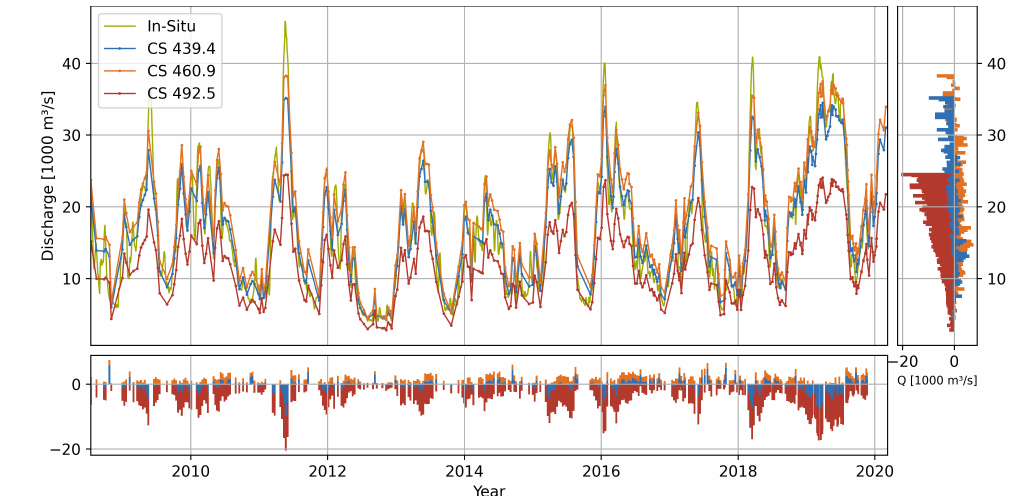
Figure 13. Discharge time series with residuals per time (horizontal) and discharge (vertical) of selected cross-sections at Tarbert